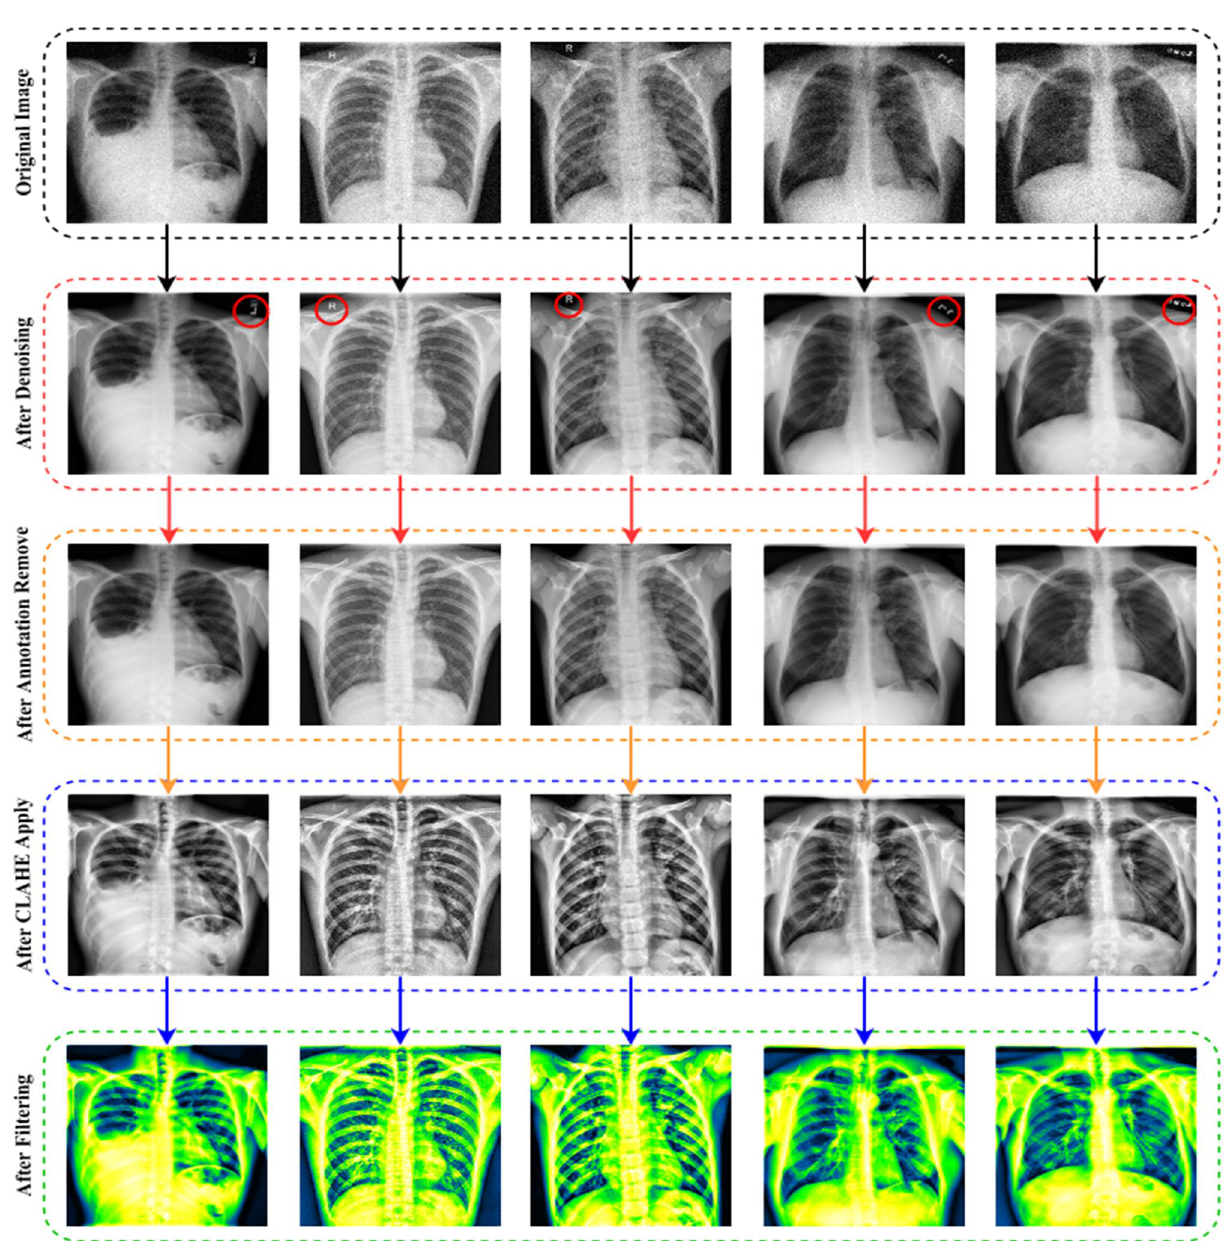
Figure 7. The final outcome following the use of all image preprocessing methods.